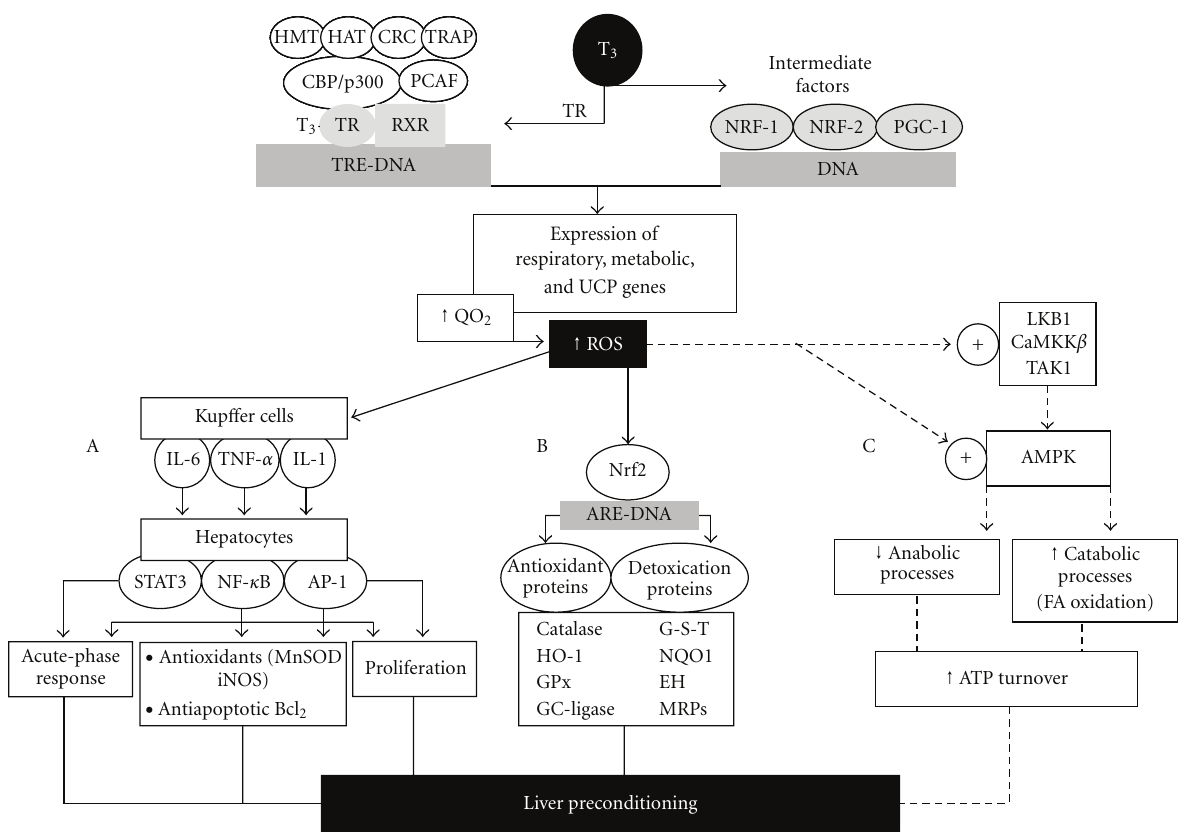
Figure 3: Genomic signaling mechanisms in T 3 calorigenesis and liver reactive oxygen species (ROS) production leading to (A) upregulation of cytokine expression in Kup ff er cells and hepatocyte activation of genes conferring cytoprotection, (B) Nrf2 activation controling expression of antioxidant and detoxication proteins, and (C) activation of the AMPK cascade regulating metabolic